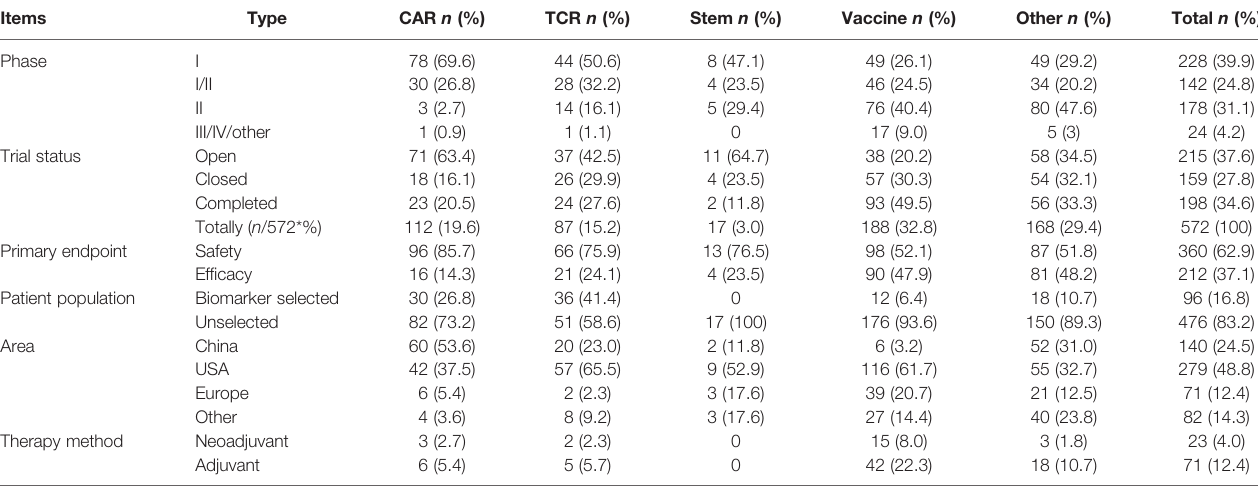
TABLE 2 | Classi fi cation and characteristics of clinical trials on cell therapy